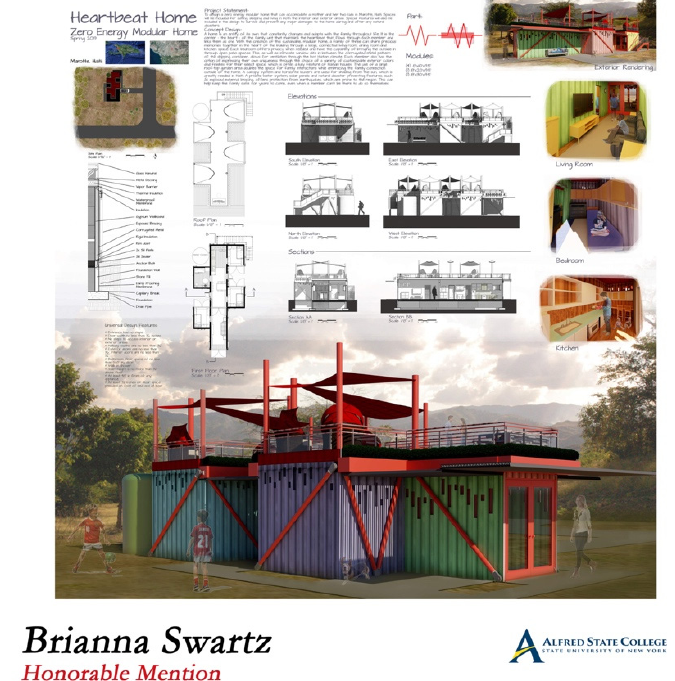
Figure 7. Containers are now “fashionable” but in the Building Beauty 2019 HOME competition the “ordinary” becomes a launching pad in the HOME competition.